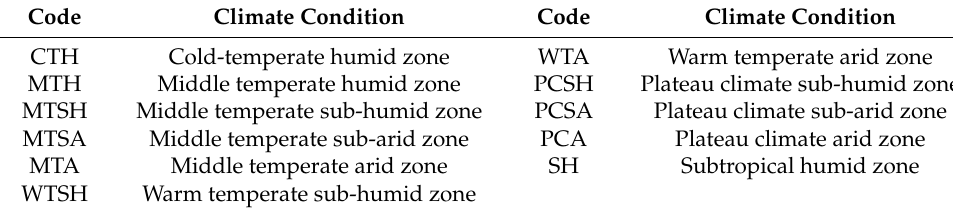
Table 1. Detailed information on 11 climate zones in the study area. Code Climate Condition Code Climate